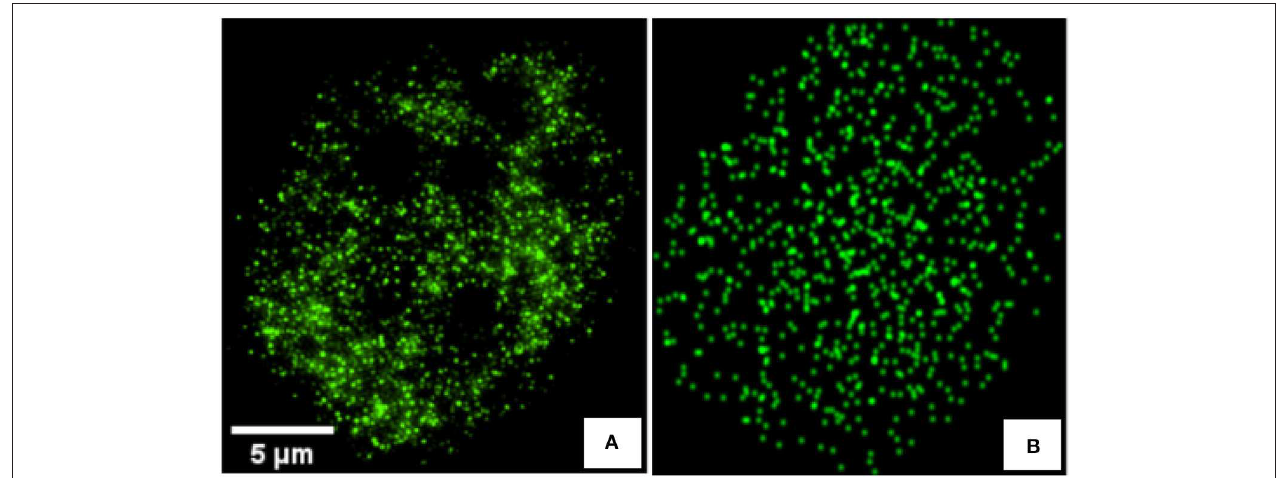
FIGURE 1 | (A) Real 2D image of a C2C12 cancerous cell immunostained using Alexa Fluor 488 antibodies and acquired with a N-SIM super-resolution microscope system (Nikon Instruments) equipped with CFI Apo TIRF 100 × 1.49 N.A oil immersion objective. (B) Synthetic image, generated to mimic image of (A) , with an heterogeneous Poisson distribution of markers and convolved by a gaussian kernel of σ psf = 0.8 simulating the